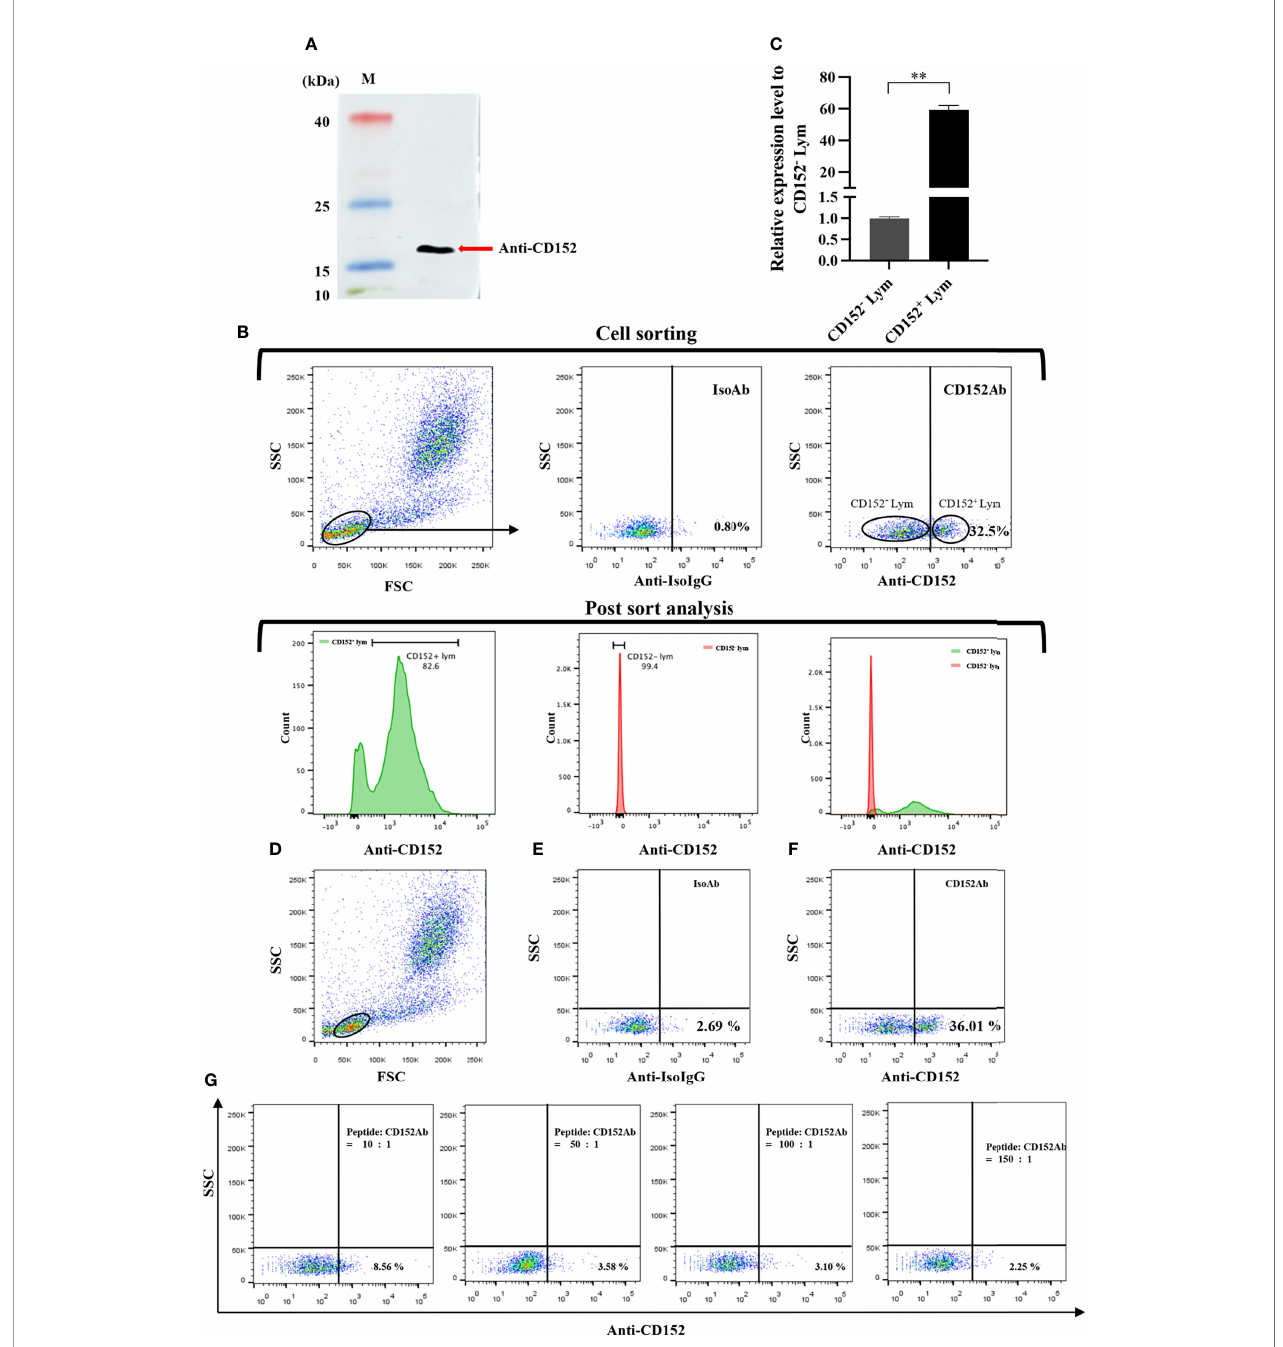
FIGURE 11 | Investigating the speci fi city of the rabbit anti-grass carp CD152 pAbs. (A) Western blot analysis of the rabbit anti-CD152 pAbs. The rabbit anti-CD1 52 pAbs can speci fi cally recognize the CD152 protein in HKLs. (B) FACS analysis of the CD152 + Lym and CD152 - Lym. The HKLs were stained with the rabbit anti-CD152 pAbs, prior to sorting the CD152 + Lym and CD152 - Lym cell populations and performing RNA isolation and cDNA synthesis. The purity of sorted cells was analyzed by fl ow cytometry. (C) The mRNA expression level of CD152 in CD152 + Lym and CD152 - Lym. (D) The gating strategy for the fl ow cytometric analysis of HKLs stained with rabbit anti-CD152 pAbs. The lymphocytes (Lym) were gated to provide further analysis of the CD152 + cells. (E) The gated lymphocytes in HKLs were stained with the rabbit IgG isotype control Abs. (F) The gated lymphocytes in HKLs were stained with the rabbit anti-CD152 pAbs. (G) The rabbit anti-CD152 pAbs were preincubated with the peptide at different molar ratios for 45 minutes, before being applied to stain the HKLs for fl ow cytometry. The mRNA expression level of CD152 was analyzed by qPCR and normalized against the expression of b -actin using the 2 − D Ct method. Fold changes were calculated by comparing the CD152 + Lym with the CD152 - Lym (de fi ned as 1). The data in (C) are presented as mean ± SEM (n = 5 fi sh). One representative result is shown in (D – G) . The p -value was calculated by one-way ANOVA with the LSD post hoc test (** p <